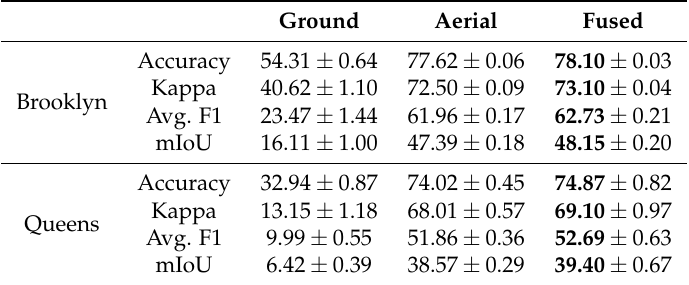
Table 2. Overall evaluation results (%).